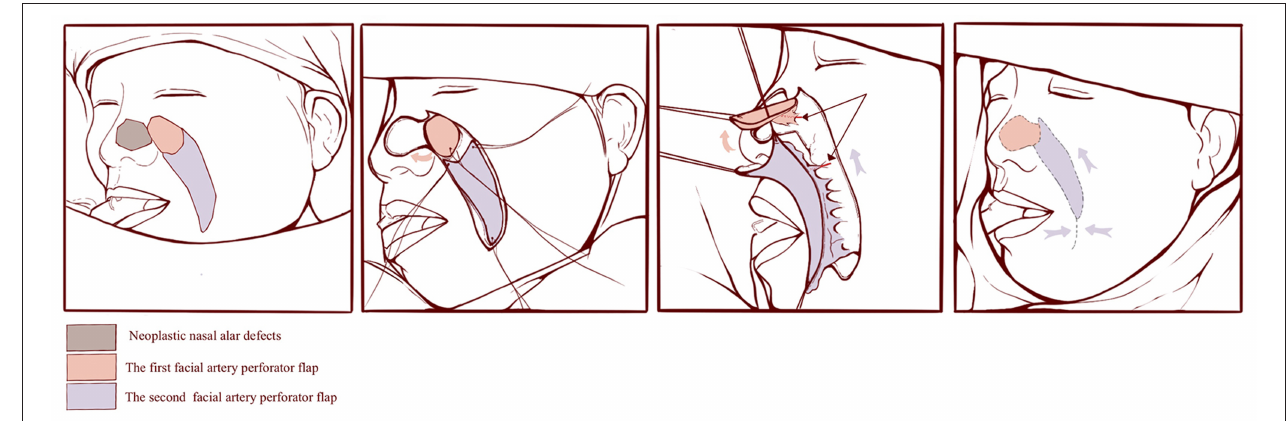
FIGURE 1 | Schematic illustration of the surgical procedures.